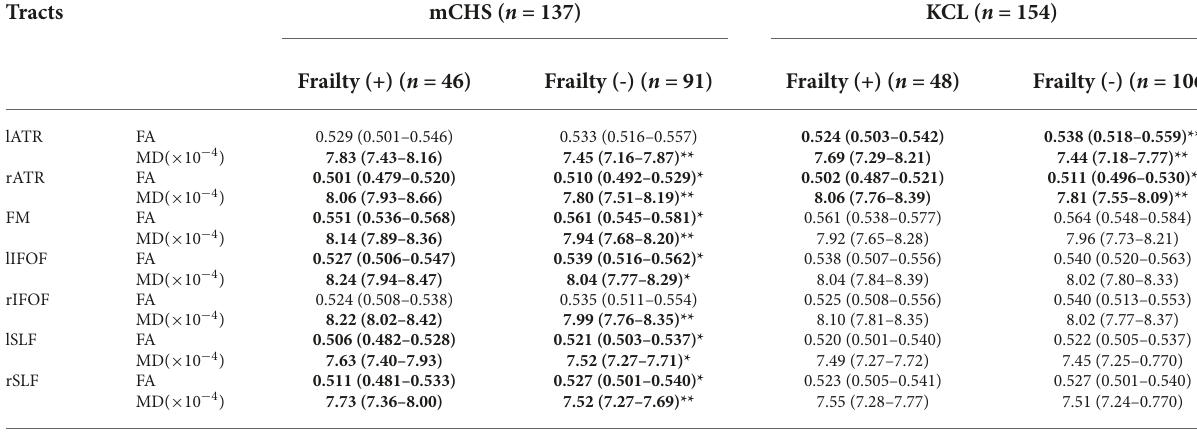
TABLE 2 Differences in FA and MD values in the tested tracts at baseline between the patients with and without frailty as defined using the mCHS and KCL. Tracts